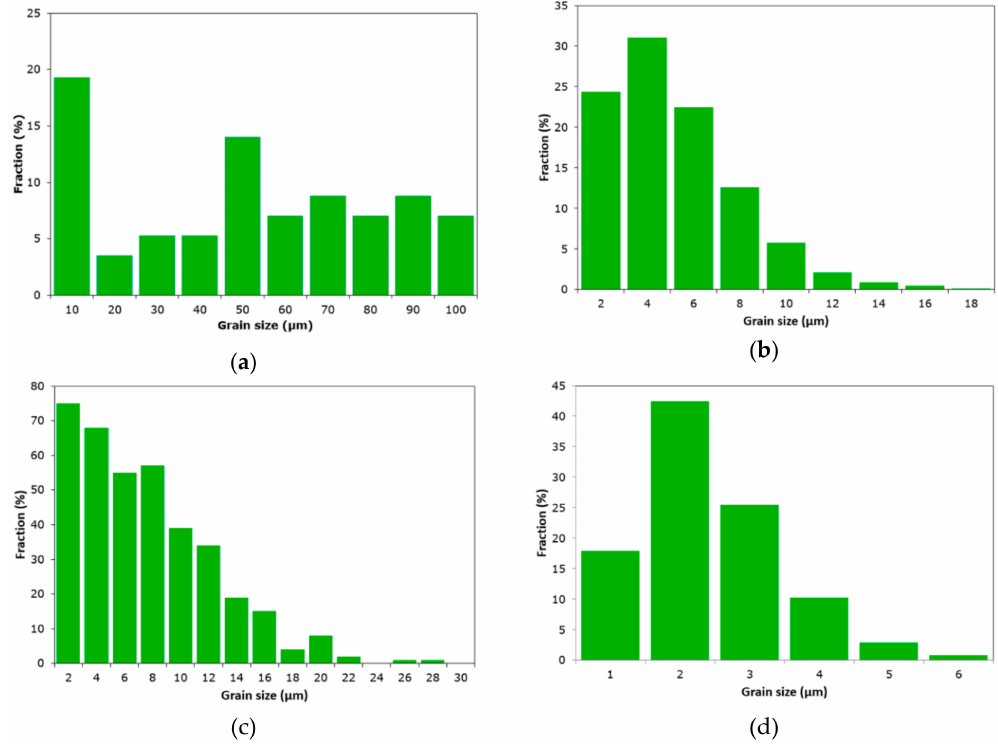
Figure 2. Grain size distributions for samples: Rotary swaged and solution treated (RS-ST) ( a ); RS + 400 RPM FSP ( b ); RS + 800 RPM FSP ( c ); RS + 1200 RPM FSP ( d